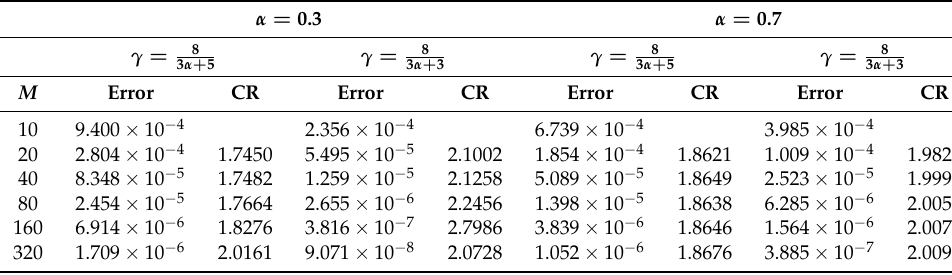
Table 2. g ( u ) = u 2 with β =